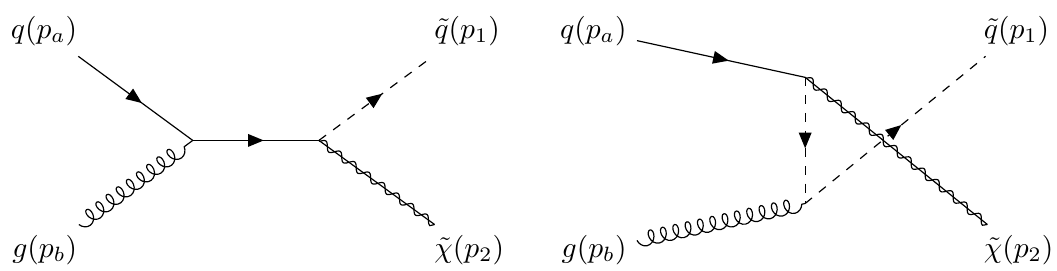
Figure 1. Tree-level s - (left) and u -channel (right) Feynman diagrams for the associated production of a squark and an electroweakino at hadron